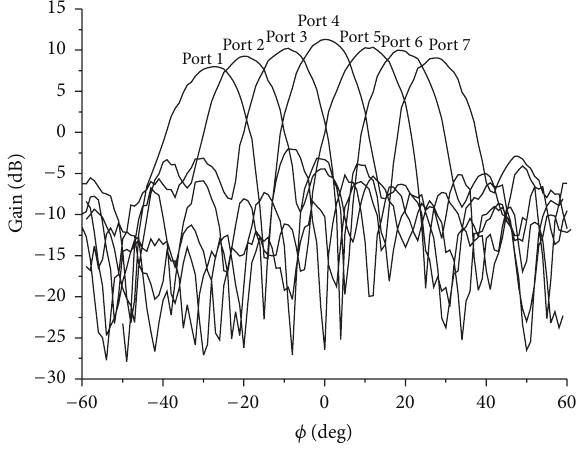
Figure 9: The integrated unit.